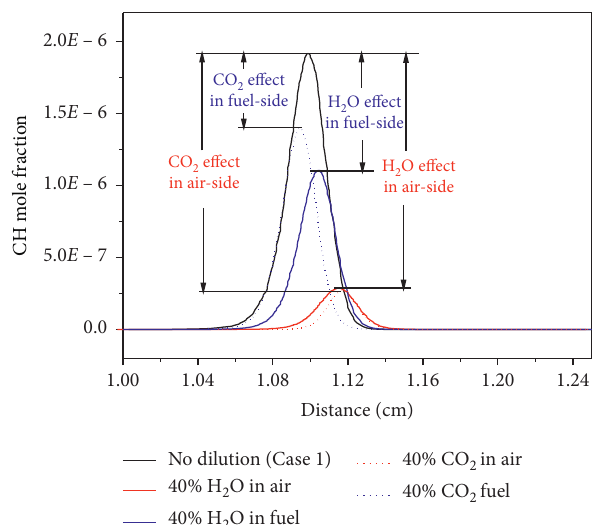
Figure 6: Distributions of CH mole fraction in CH 4 /air counterflow diffusion flames with and without 40% H 2 O and 40% CO 2 dilution on the air and fuel sides: a s � 50s − 1 , L � 2 cm,